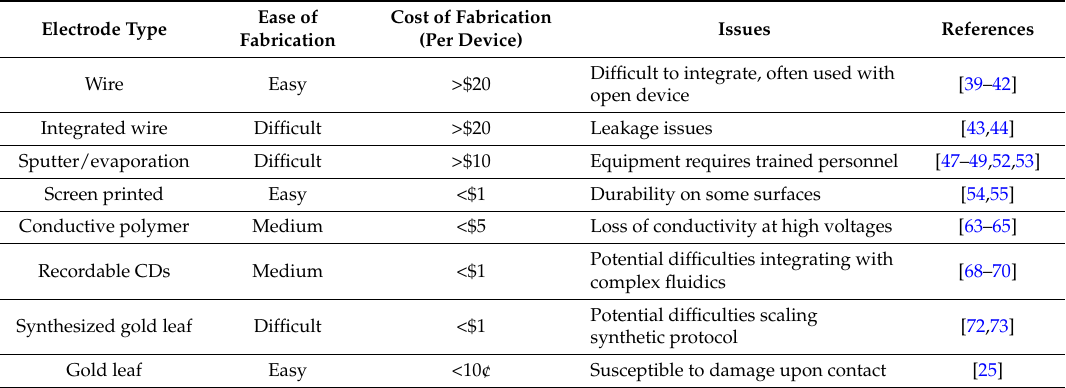
Table 2. Summary of current methodologies for integrating electrodes in microfluidic